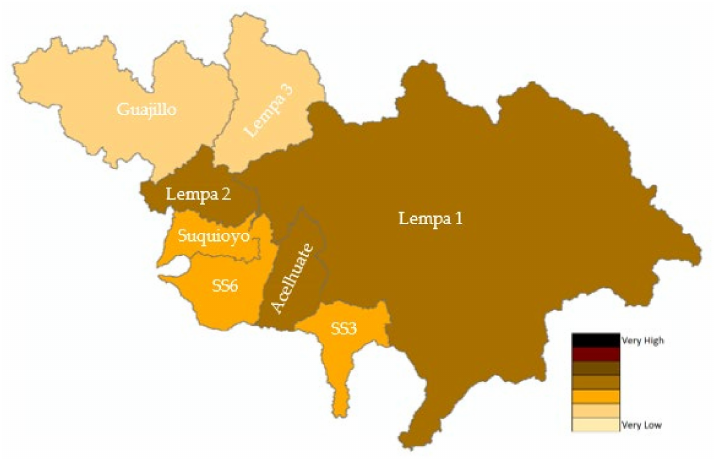
Figure 9. Spatial variation of drought hazard index (DHI) in eight sub-basins of Lempa River basin based on